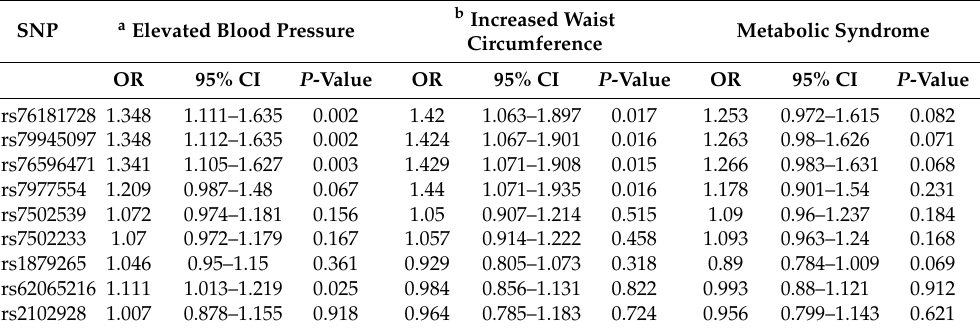
Table 2. Case–control study to evaluate the associations among the significant SNPs and hypertension, increased waist circumference, and metabolic syndrome. OR: odds ratio; CI: confidence interval.